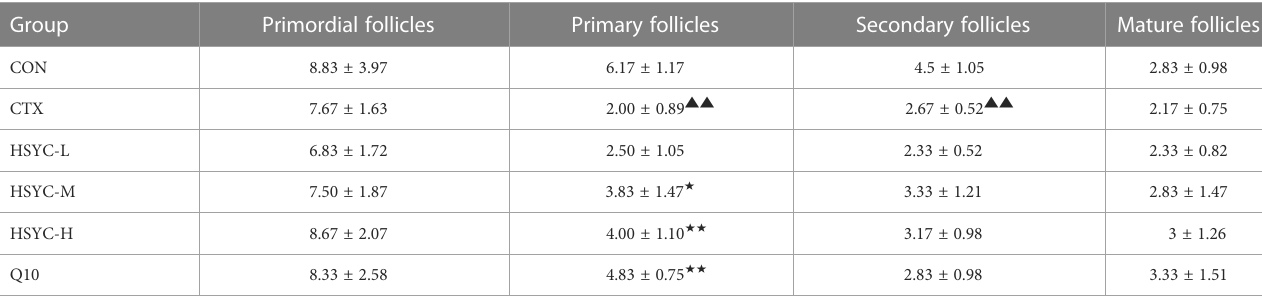
TABLE 3 Differential follicle count in the ovaries of each group.